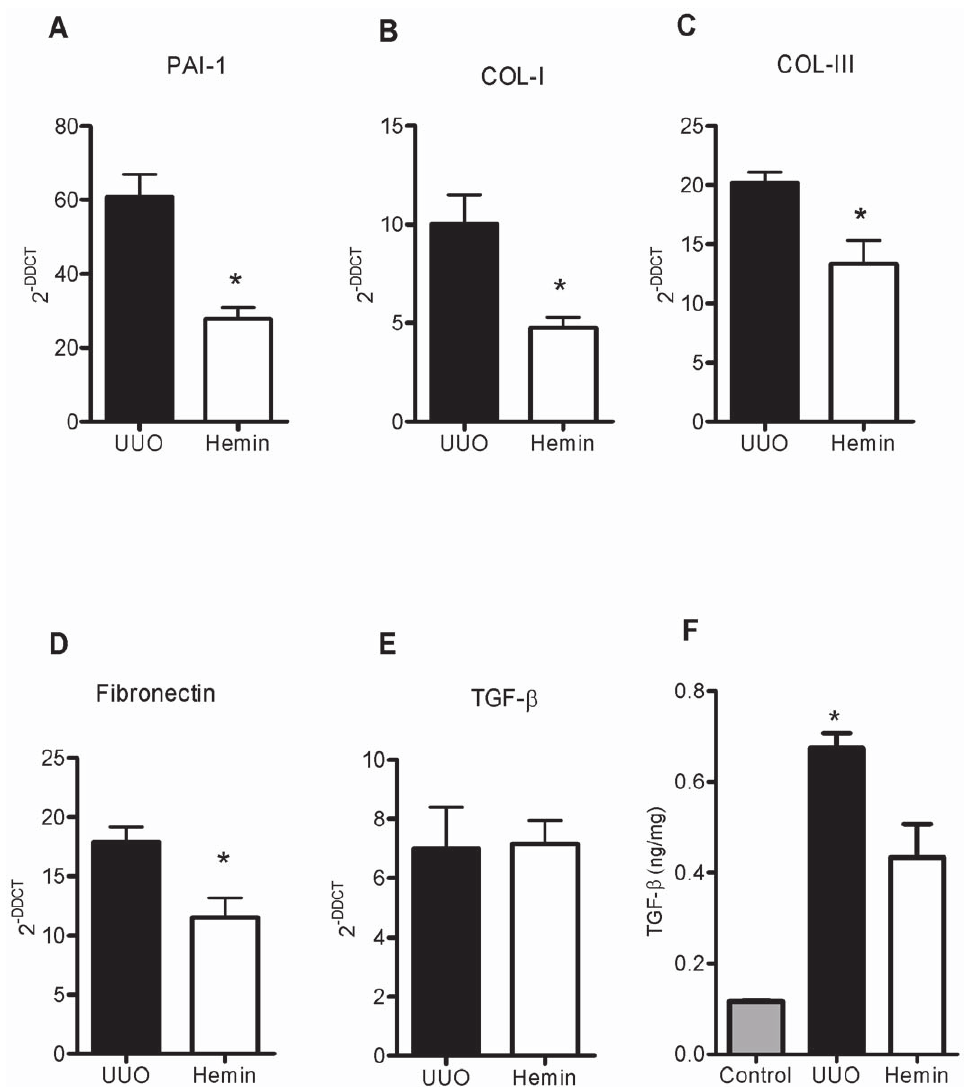
Figure 12. Treatment with Hemin after UUO markedly downregulates gene and protein expression of molecules associated with fibrosis. (A) Samples from obstructed kidneys of UUO and Hemin-treated animals were processed and RT-PCR for PAI-1(panel A), collagen types I and III (panels B and C), fibronectin (panel D) and TGF- b (panel E) was performed (average 6 s.e.m.). Gene expression in control animals was assigned a value of 1. * p , 0.05 vs. UUO. (F) ELISA assay for total TGF- b protein production in obstructed kidney from UUO and Hemin-treated animals. The amount of TGF- b quantified was divided by total tissue protein. * p , 0.05 vs. Control and Hemin.